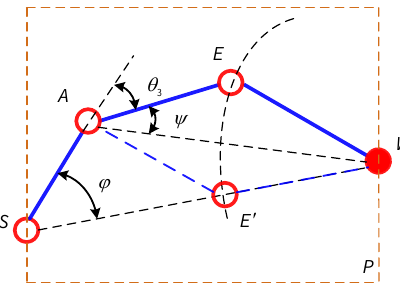
Figure 5. Geometric relationship of joint 2.